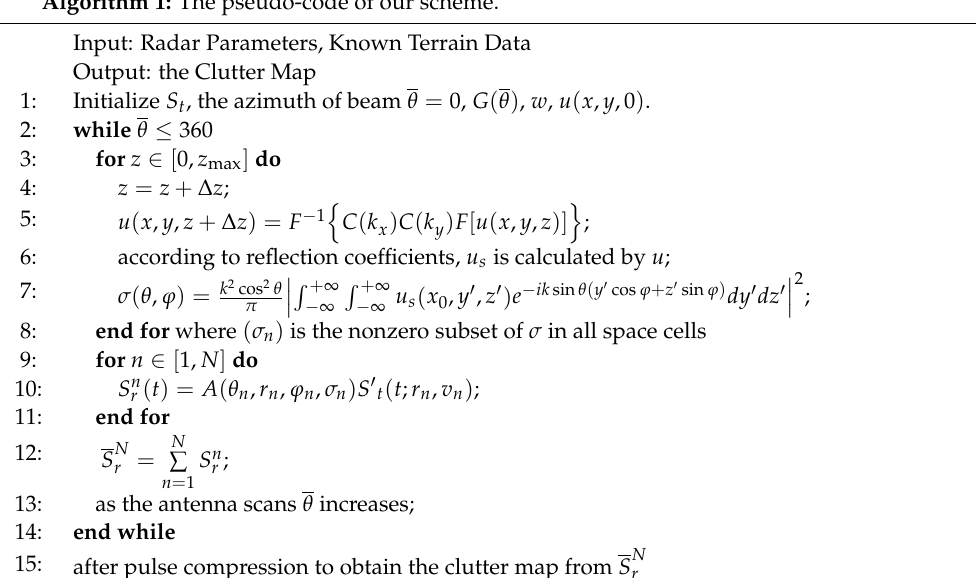
Algorithm 1: The pseudo-code of our